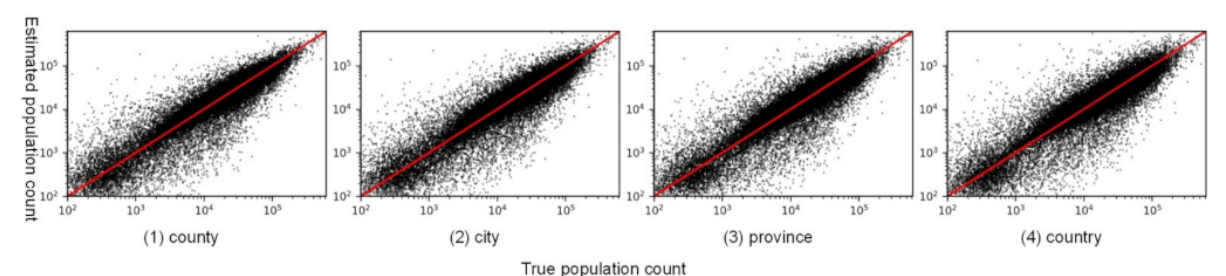
Figure 12. Scatterplots of the true population count and estimated population count at town scale based on county-scale, city-scale, province-scale, and country-scale census data.